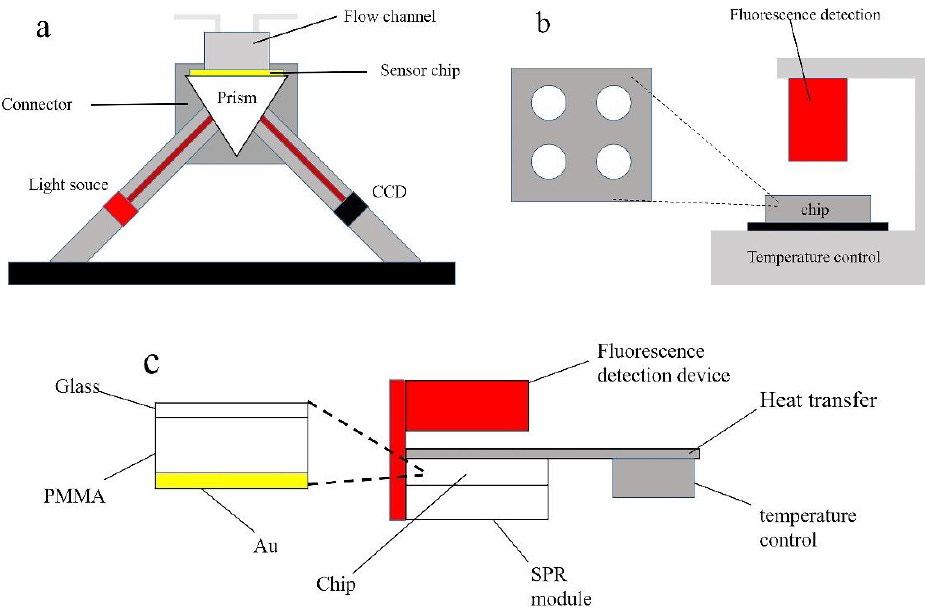
Figure 1. ( a ) Schematic of independent SPR system composed of light source, CCD camera, flow cell, prism and gold layer. ( b ) Schematic of the independent fluorescence detection system consisting of heating module and microfluidic chip. ( c ) Schematic of the integrated device of fluorescence detection, SPR module, temperature, and chip.